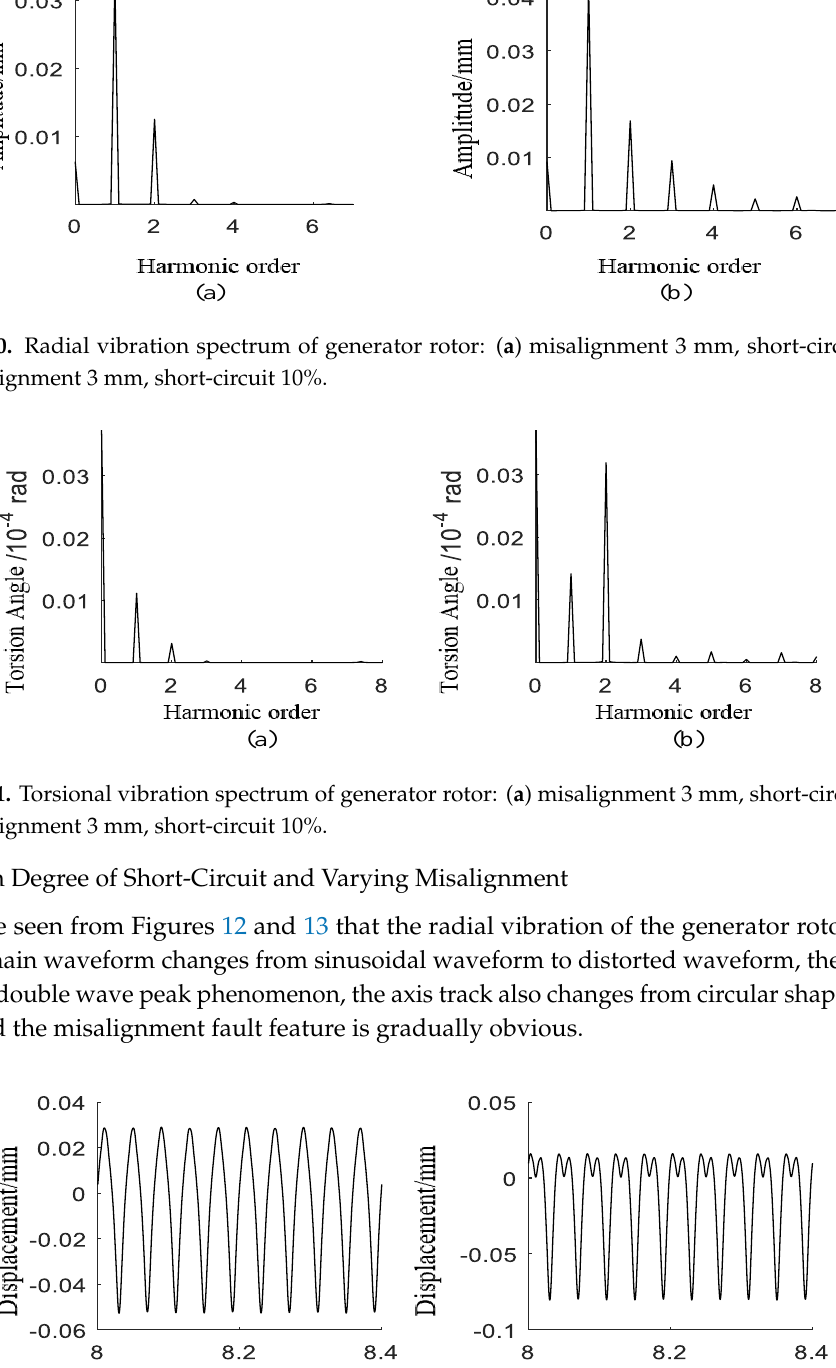
(b) Figure 13. Vibration response axis locus of generator rotor: ( a ) misalignment 1.5 mm, short-circuit 5%; ( b ) misalignment 5 mm, short-circuit 5%. As shown in Figures 14 and 15, when the amount of the stator short-circuit is fixed, with the increase of misalignment degree, the 2.0 harmonic component of the radial vibration signal increases obviously, the 4.0 and 6.0 harmonic components gradually highlight, the 1.0 harmonic component of the torsional vibration signal increases sharply, and the 3.0 and 5.0 harmonic components gradually appear. (a) (b) Figure 14. Radial vibration spectrum of generator rotor: ( a ) misalignment 1.5 mm, short-circuit 5%; ( b ) misalignment 5 mm, short-circuit 5%.